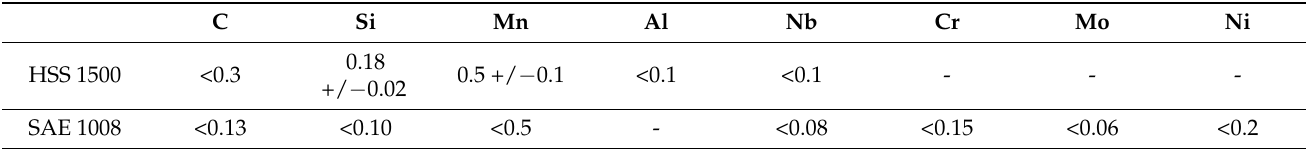
Table 1. Chemical compositions of the investigated materials (wt. %).